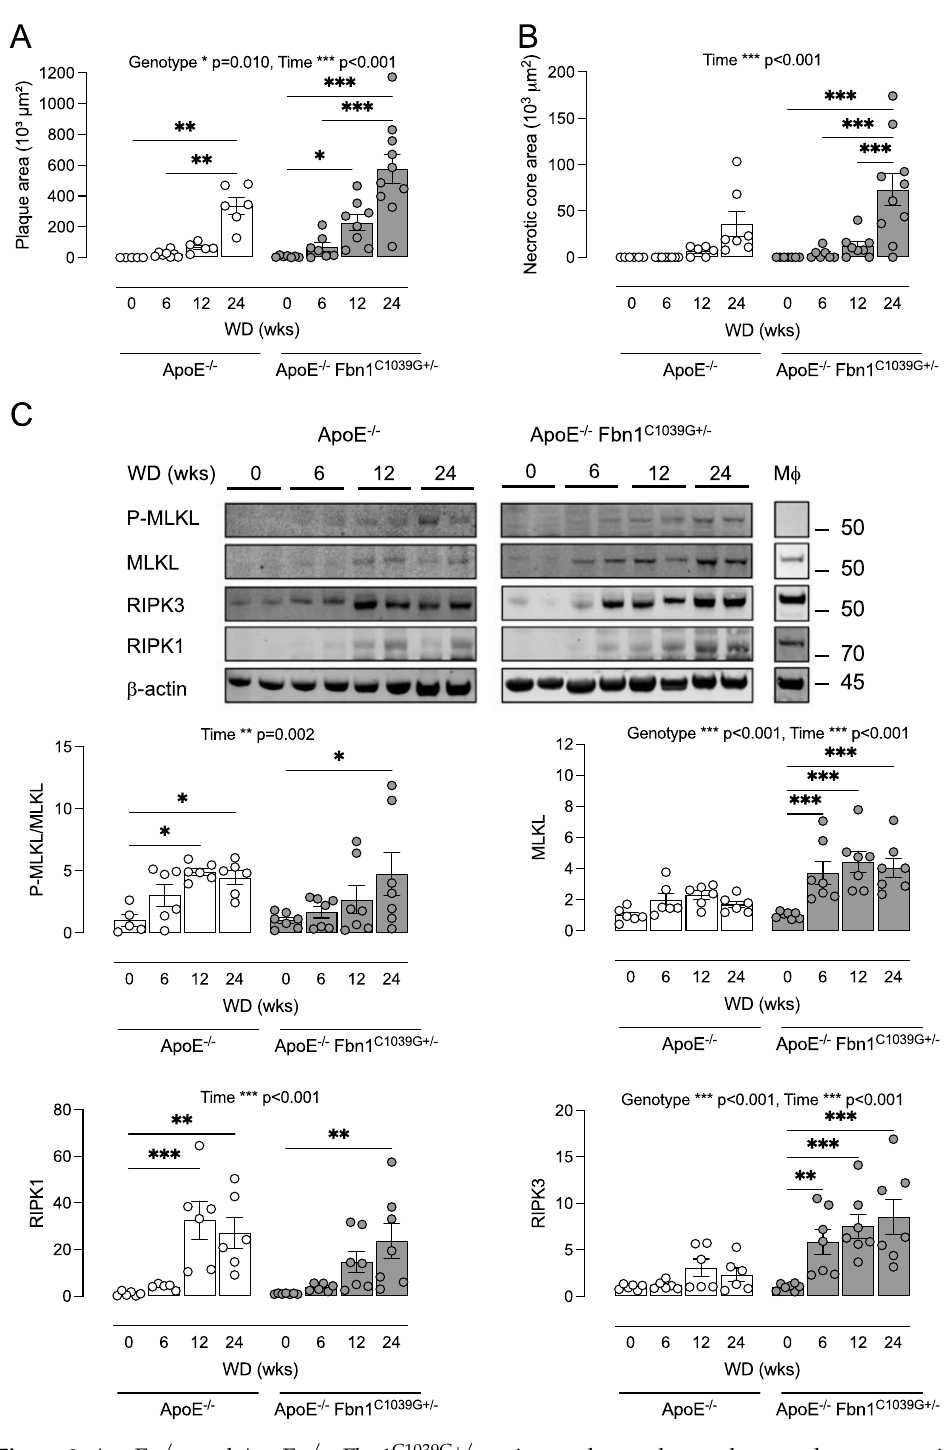
Figure 3. ApoE −/− and ApoE −/− Fbn1 C1039G +/− mice can be used as tools to study necroptosis in athero- sclerosis. ApoE −/− and ApoE −/− Fbn1 C1039G +/− mice (genotype factor) were fed a western-type diet (WD) for 6, 12, and 24 weeks (time factor). Sections of the proximal ascending aorta were stained with hematoxylin/eosin to measure ( A ) plaque size and ( B ) necrotic core area. ( C ) Expression of necrop- tosis proteins (MLKL, RIPK1, RIPK3) was analyzed via Western blotting in plaque lysates of the aortic arch as well as in bone marrow- derived macrophages (Mφ) of wild -type mice. * p < 0.05, ** p < 0.01, *** p < 0.001 vs. 0 weeks WD (two- way ANOVA followed by Dunnett’s post hoc test between timepoints per genotype, n = 6 – 10 mice per group).